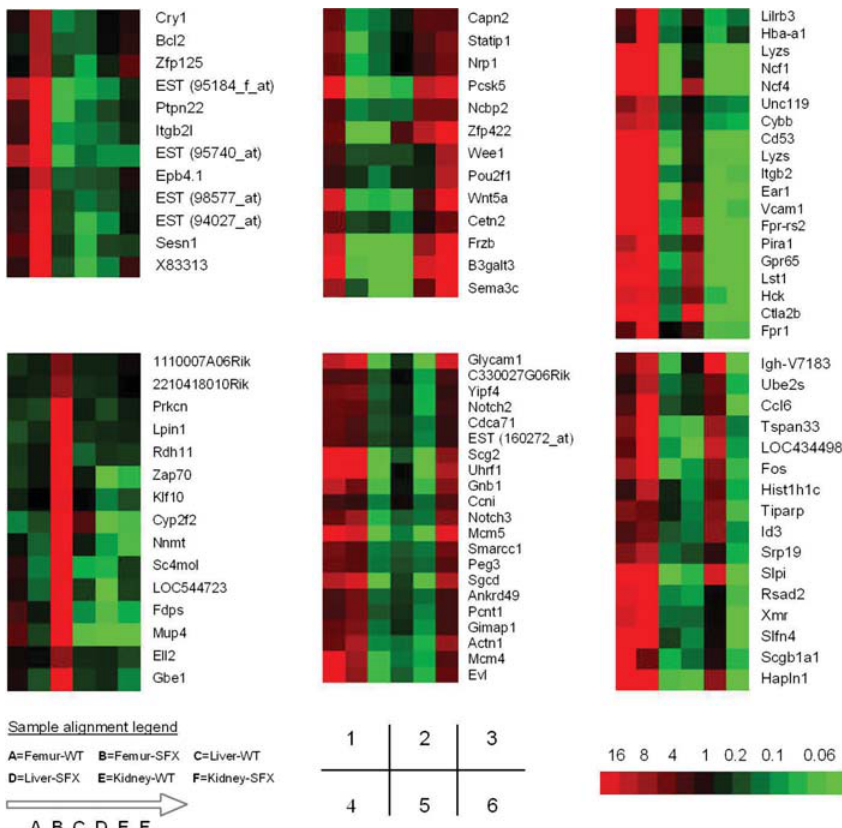
Figure 1 - Hierarchical clustering results of dysregulated genes in the sfx mice. One thousand and twenty eight differentially expressed genes with a fold change value of ≥ 2 were chosen for hierarchical clustering, using the Cluster and TreeView software. Six major clusters with a correlation coefficient valueof ≥ 0.9andmorethan10transcriptswereidentifiedinfemur(clusters1and2),liver(clusters3and4),andkidney(clusters5and6).Samplealign- ment legend is shown in the down-left corner. The probe-to-transcripts hybridization signal intensity in a microarray is indicated by color, from low (green) to high (red). A group of genes with the same or similar color indicates that they have the same or similar expression levels. The relative fold change for a transcript can be estimated based on the color scale in the down-right